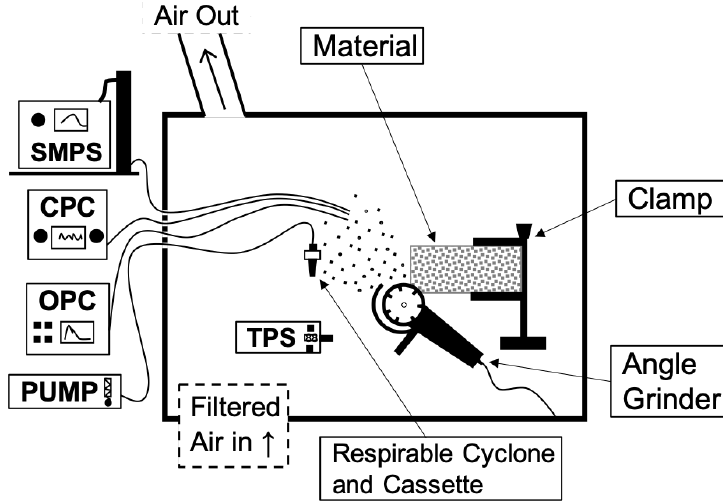
Figure 1. Experimental apparatus schematics. SMPS, scanning mobility particle spectrometer; CPC, condensation particle counter; OPC, optical particle counter; TPS, thermophoretic sampler; PUMP, air pump.